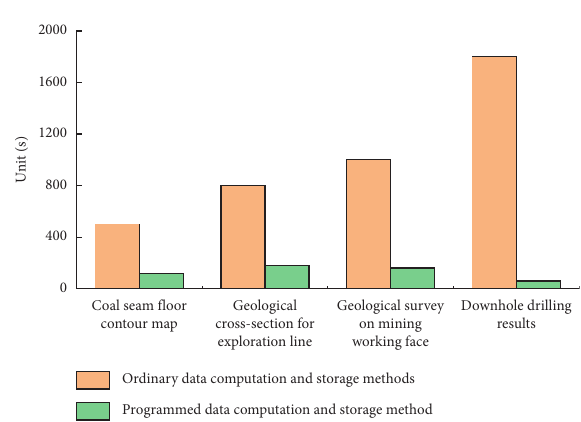
Figure 3: Comparison of the time efficiency of different geological data extraction methods.